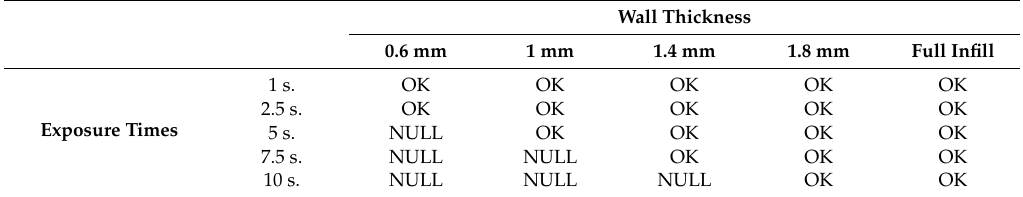
Table 8. Simple compression strength test for di ff erent wall thicknesses and exposure times with a layer height of 0.18 mm.